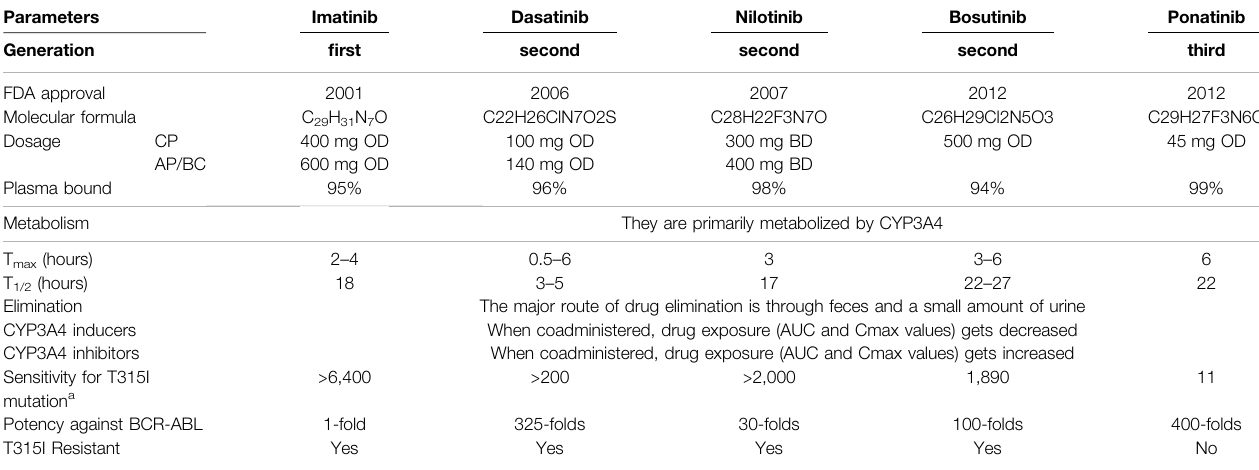
TABLE 1 | Clinical parameters of different TKIs approved by FDA to treat